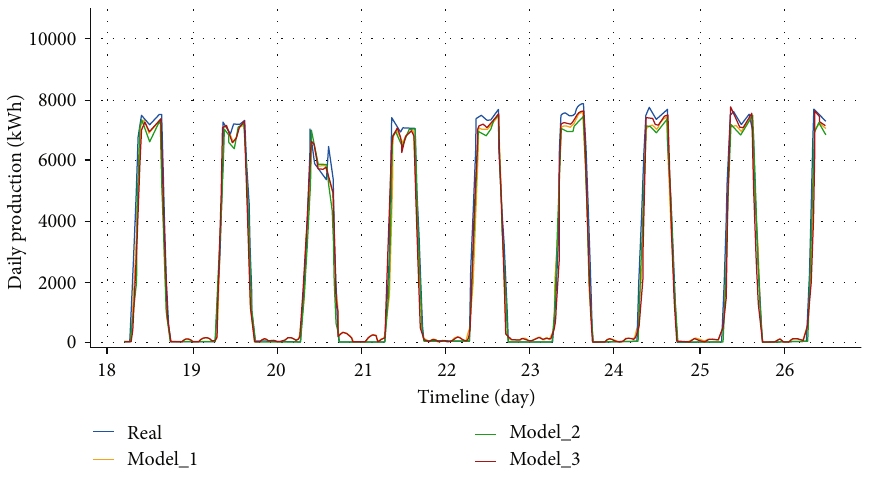
Figure 10: Forecasting of the selected